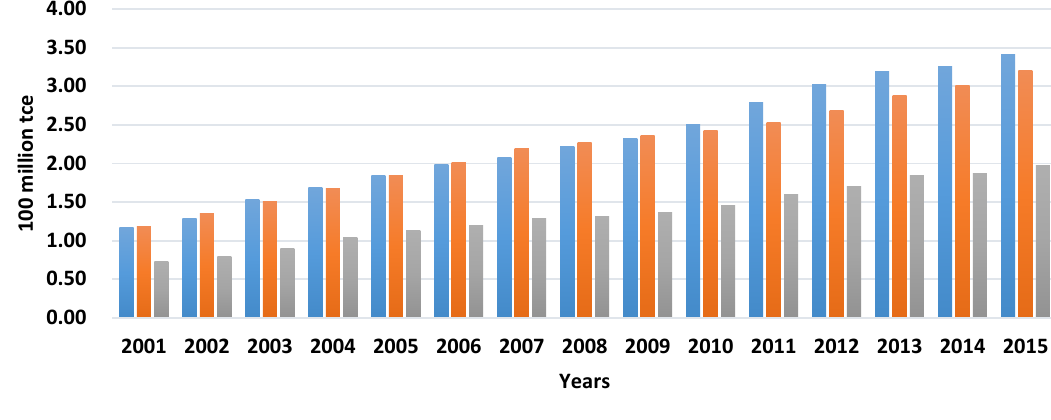
Figure 4. Building Energy Consumption by Categories in China.